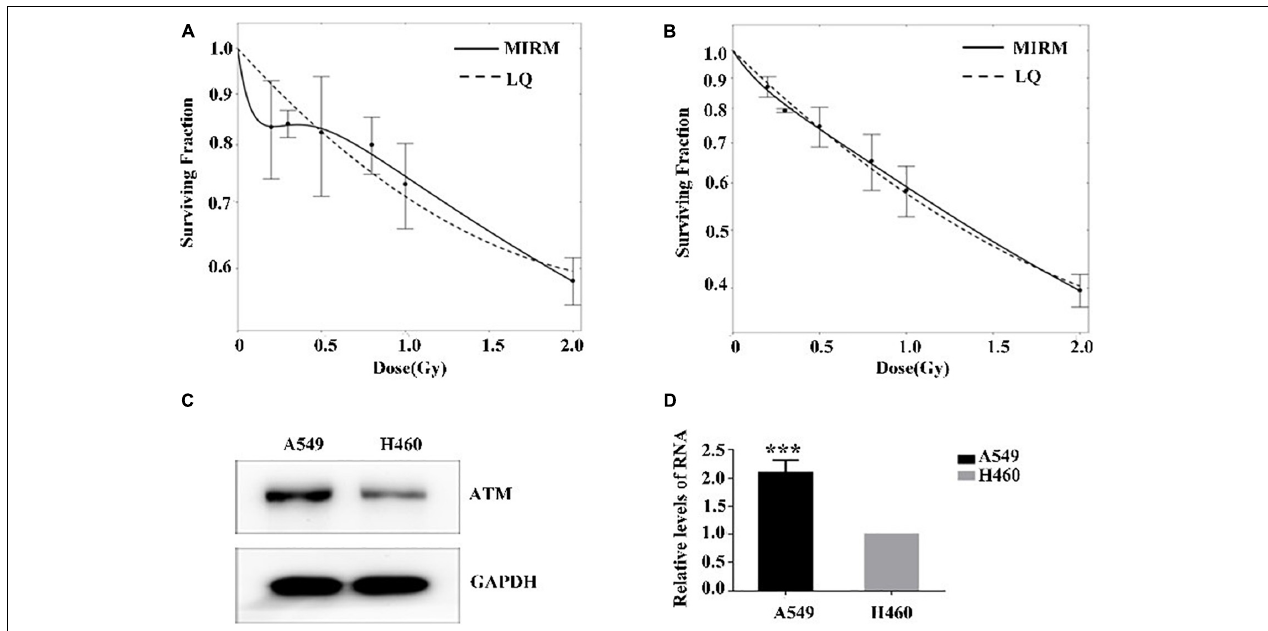
FIGURE 1 | Low-dose radiosensitivity and ATM protein expression in A549 cells and H460 cells. (A) A549 cells showed radioresistance to 0.3–0.5 Gy. (B) The radiosensitivity of H460 cells was dose-dependent. (C,D) The mRNA and protein levels of ATM in A549 cells were both higher than those of H460 cells. *** p <